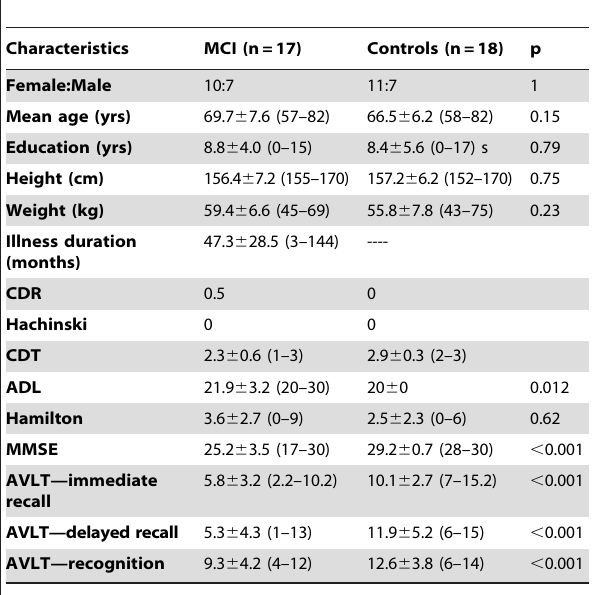
Table 3. Demographic information for treatment naı¨ve MCI patients and the healthy